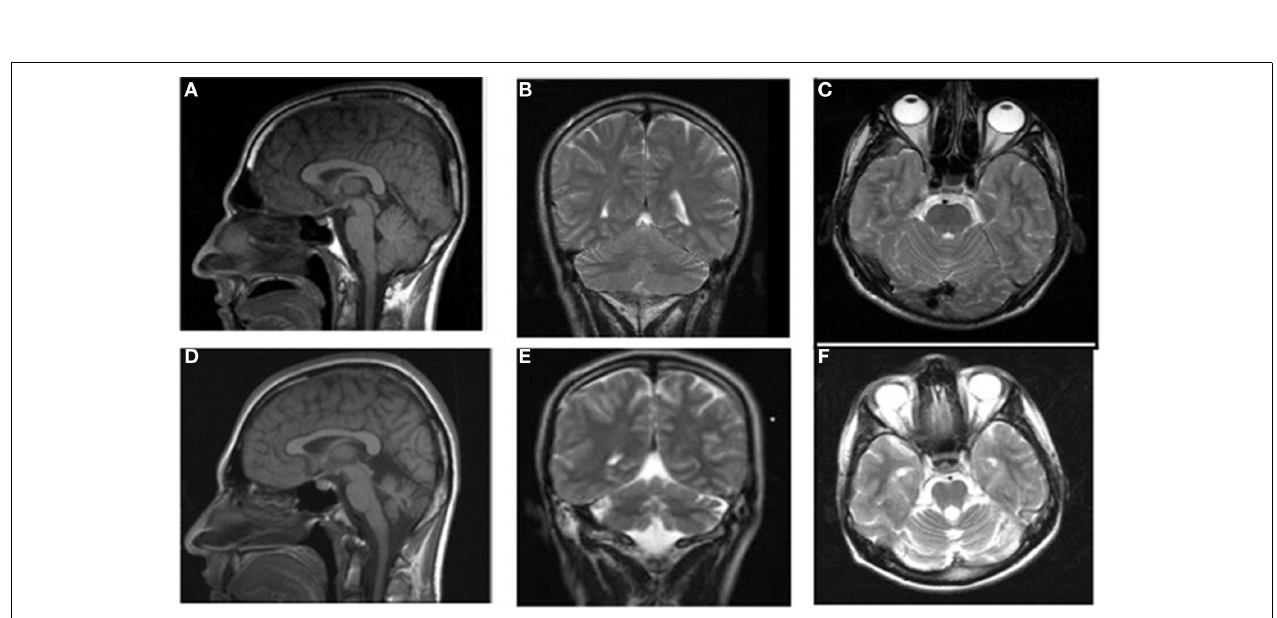
FIGURE 7 | MRI scans from a healthy subject: sagittal (A), coronal (B), and axial (C) and the patient IV-24: sagittal (D), coronal (E), and axial (F).